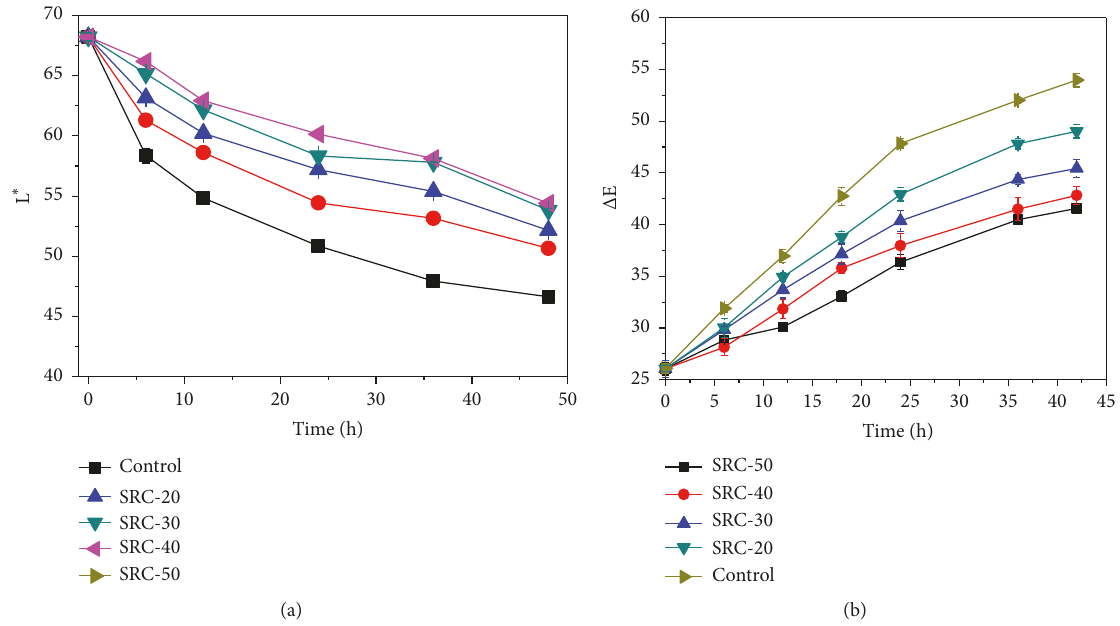
Figure 8: The changes of the color difference of the fresh cut potatoes coated with the SRC microparticles.